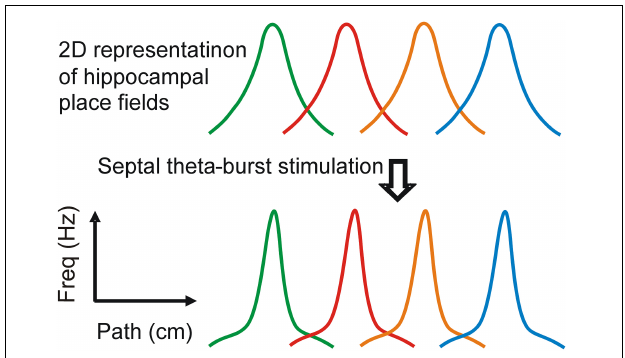
FIGURE 2 | Attentional regulation of the spatial representation. Stimulation of the medial septum changes the properties of the place fields: spatial coherence, spatial information and center firing rate (based on the data from Mamad et al., 2015). The effect on the place field shape is demonstrated in two-dimentionally-represented place fields. Each place field represents the spiking of a separate place cell along linear